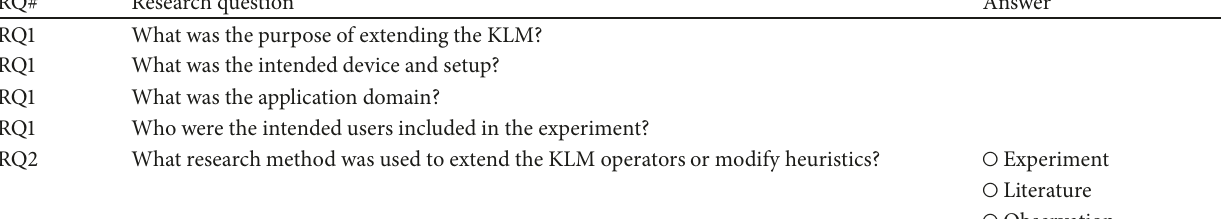
Table 15: Data extraction